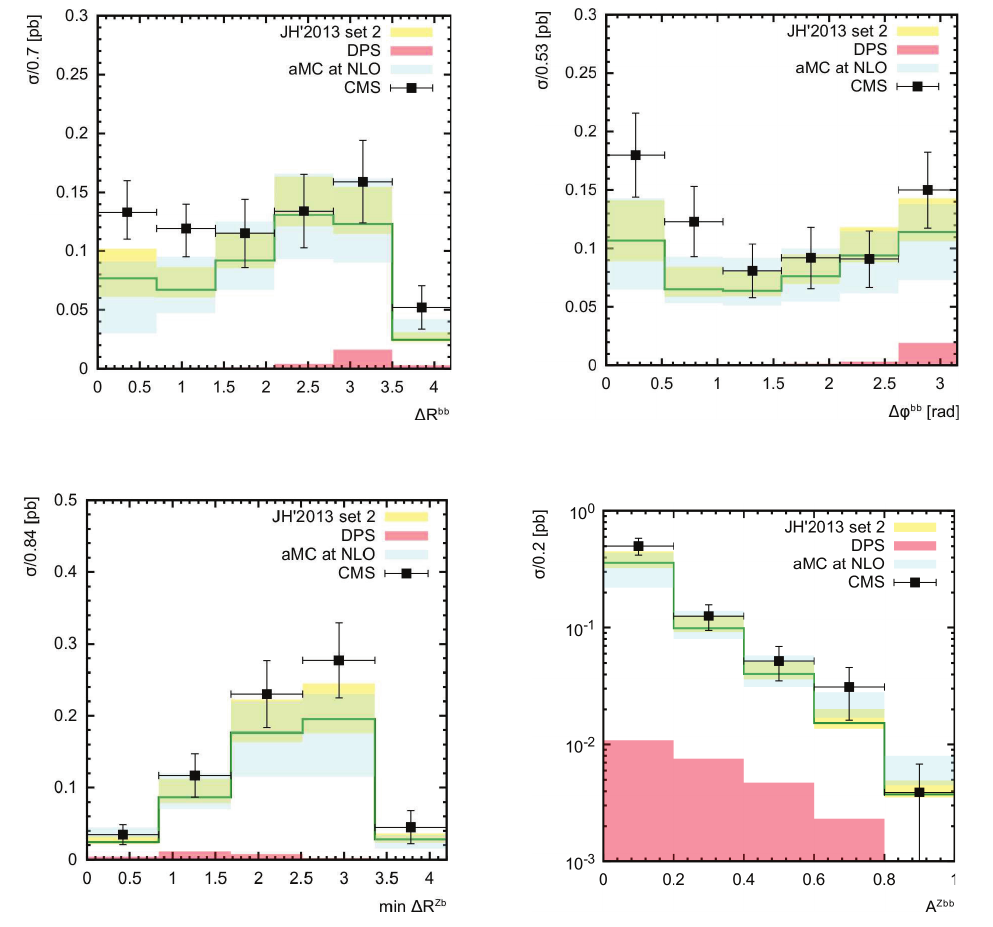
Figure 3. Associated production of a Z boson with two beauty jets at √ s = 7 TeV calculated as a function of the Figure 4. Associated production of a Z boson and two b -hadrons at √ s = 7 TeV. Notation of the histograms is Z boson transverse momentum, rapidity, invariant mass of the b -jet pair and angular separation between the jets. the same as in Fig. 1. The data are from CMS [2]. The aMC@NLO [29] predictions are taken from Notation of the histograms is the same as in Fig. 1. The data are from ATLAS [3]. The MCFM [28] predictions are taken from [3].